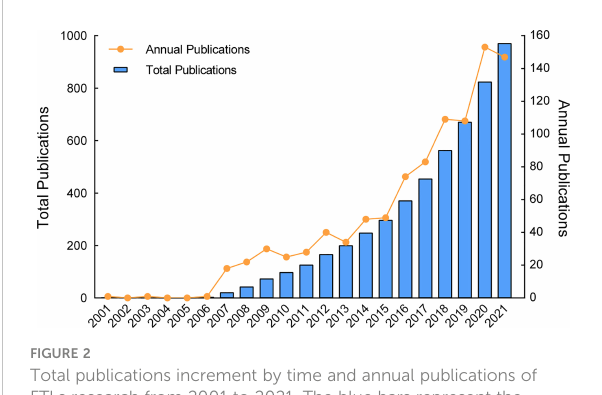
FIGURE 2 Total publications increment by time and annual publications of FTLs research from 2001 to 2021. The blue bars represent the accumulation of articles, while the orange line indicates the yearly scienti fi c